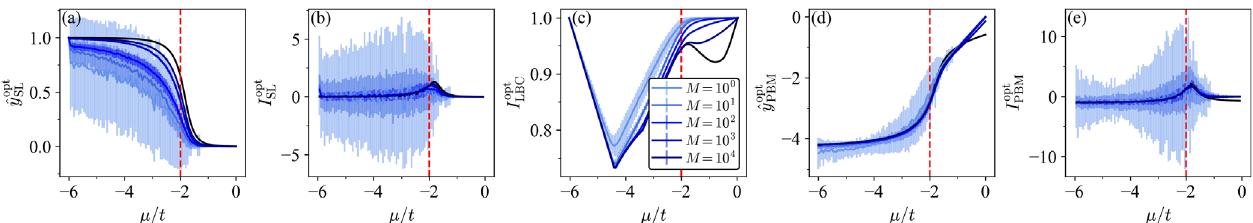
FIG. 10. Optimal predictions and indicators of SL, LBC, and PBM for the Kitaev chain ( L ¼ 20 ) with a varying number of data points 0 , and Δ p ¼ 0 . 06 . In SL, the data obtained at p M per sampled value of the tuning parameter p ¼ μ =t , where p 1 ¼ − 6 , p 1 and p K K ¼ 1 and l K . The critical value μ =t ¼ − 2 is highlighted by a red dashed line. The optimal constitute our training set, i.e., r c I ¼ II ¼ predictions and indicators obtained based on the ground-truth probability distributions from exact diagonalization are shown in black. in SL and (b) the corresponding indicator I opt . (c) Optimal indicator of LBC, I opt . (d) Mean optimal (a) Mean optimal prediction ˆ y opt SL SL LBC in PBM and (e) the corresponding indicator I opt . Here, we report results averaged over 100 independent datasets, prediction ˆ y opt PBM PBM where the error bars correspond to the standard